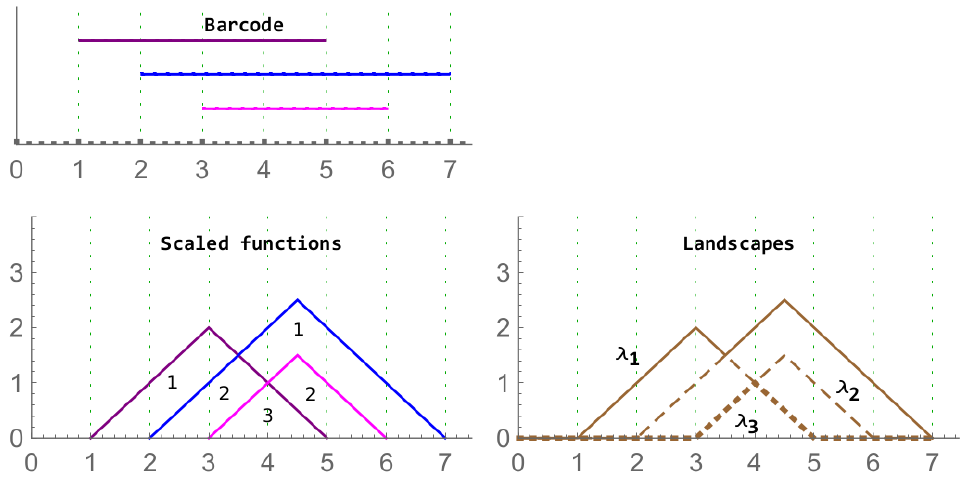
Figure 5. Left column: A barcode ( top ) and its corresponding rescaled rank functions ( bottom ). The values of the functions in the corresponding region are provided. On the right , the associated landscape with the functions λ 1 , λ 2 , and λ 3 are displayed with different